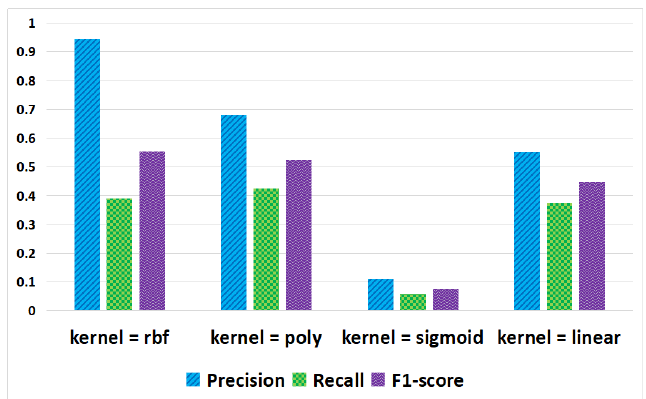
Figure 13. Results of using the support vector machine (SVM) classification model for traceability link recovery with different kernel functions on the SMOS